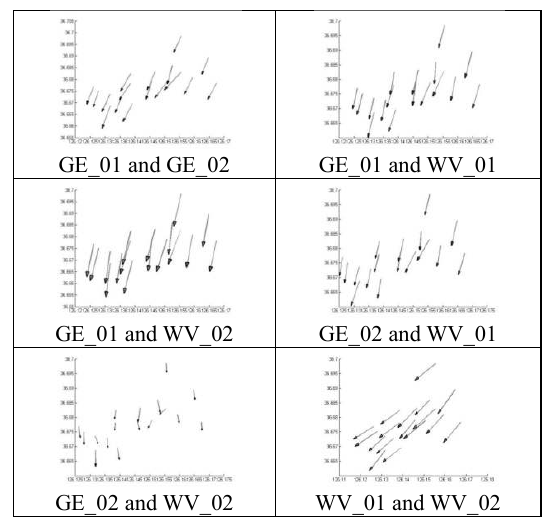
Figure 4. Residuals of stereo models without GCPs